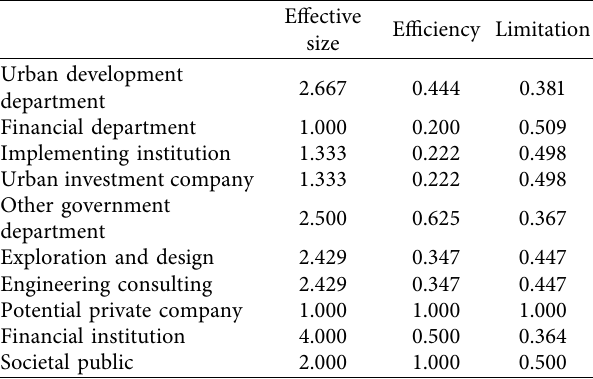
Table 5: Trust network structure hole index.